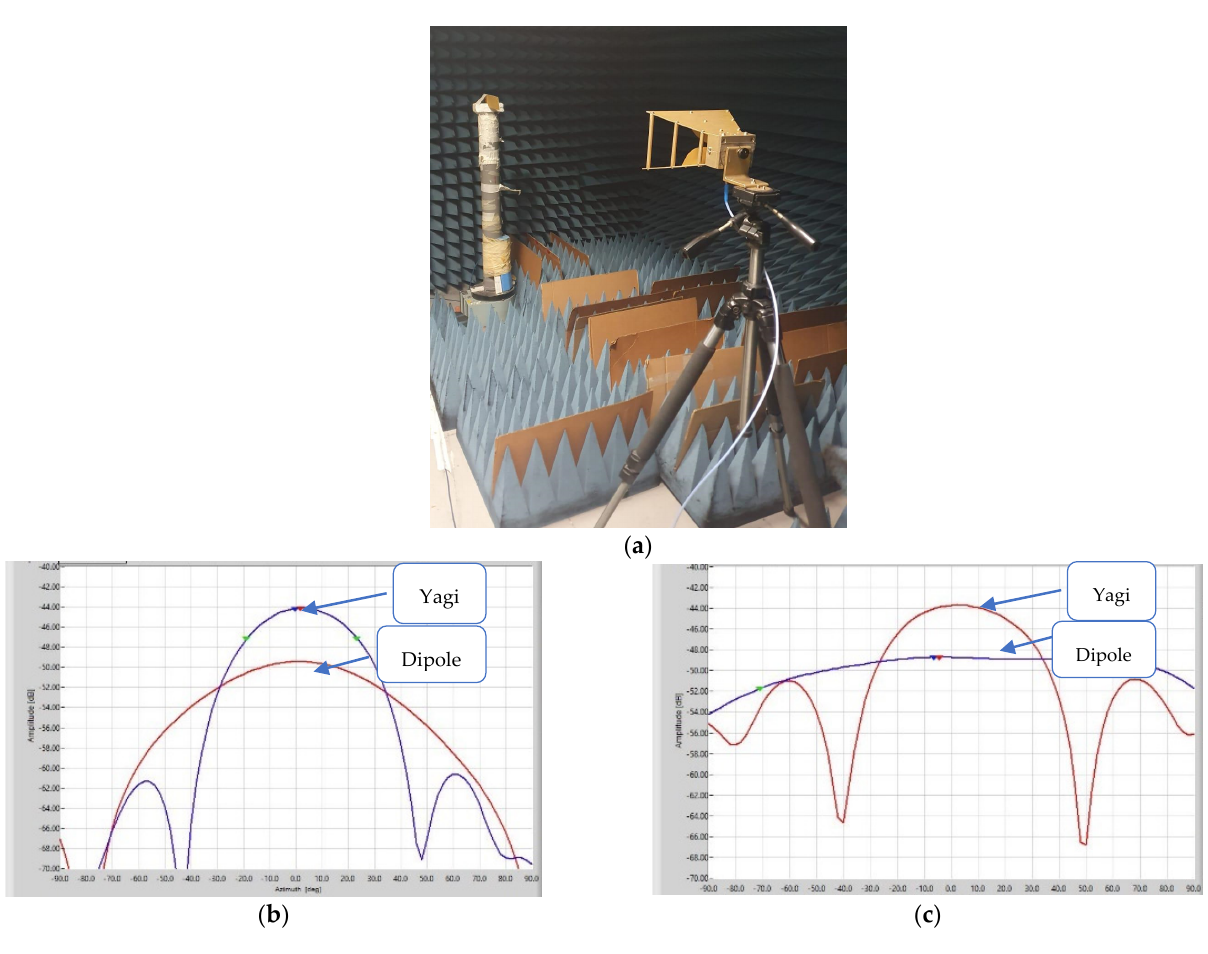
Figure 8. ( a ) Farfield antenna measurement setup ( b ) Horizontal gain measurements of the Yagi–Uda and dipole element; ( c ) Elevation gain measurements of the Yagi–Uda and dipole element.